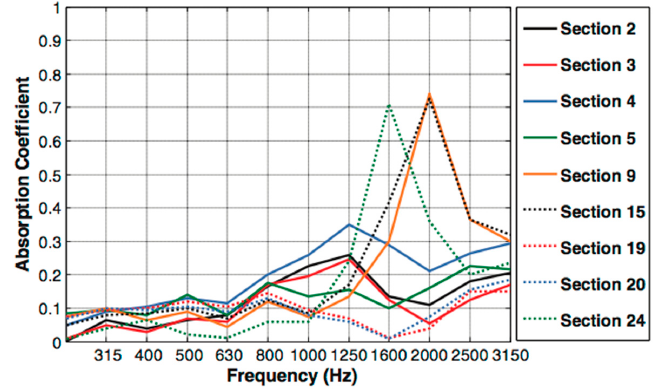
Figure 26. Sound absorption coefficients for the thin-layer surfacing sections (source from Li et al., 2015 [193], Figure 4; reprinted with permission from American Society of Civil Engineers).